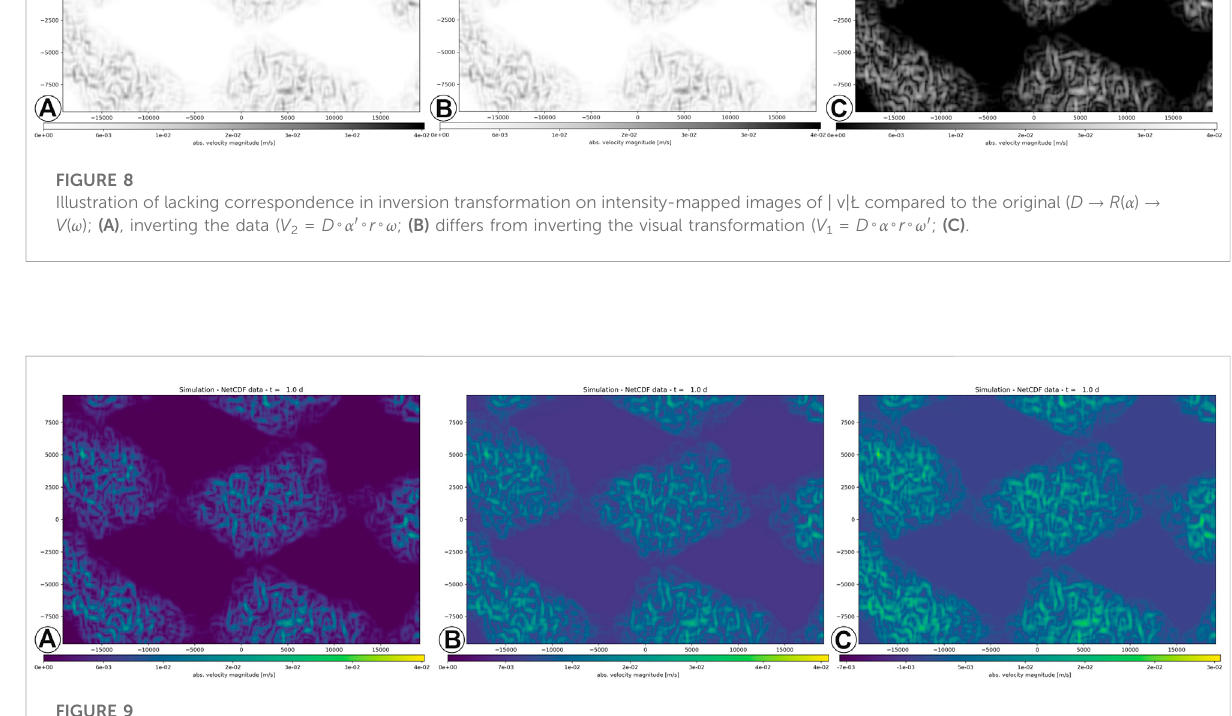
FIGURE 9 A hue-graded colour mapping of | (cid:1) v | shows a pronounced shift jumbler of | (cid:1) v | , due to the uneven brightness distribution. Here, D ◦ α ′ ◦ r ◦ ω ≠ D ◦ α ◦ r ◦ ω ′ . The fi gure compares the original (A) with the data inversion (B) and the visual inversion (C)